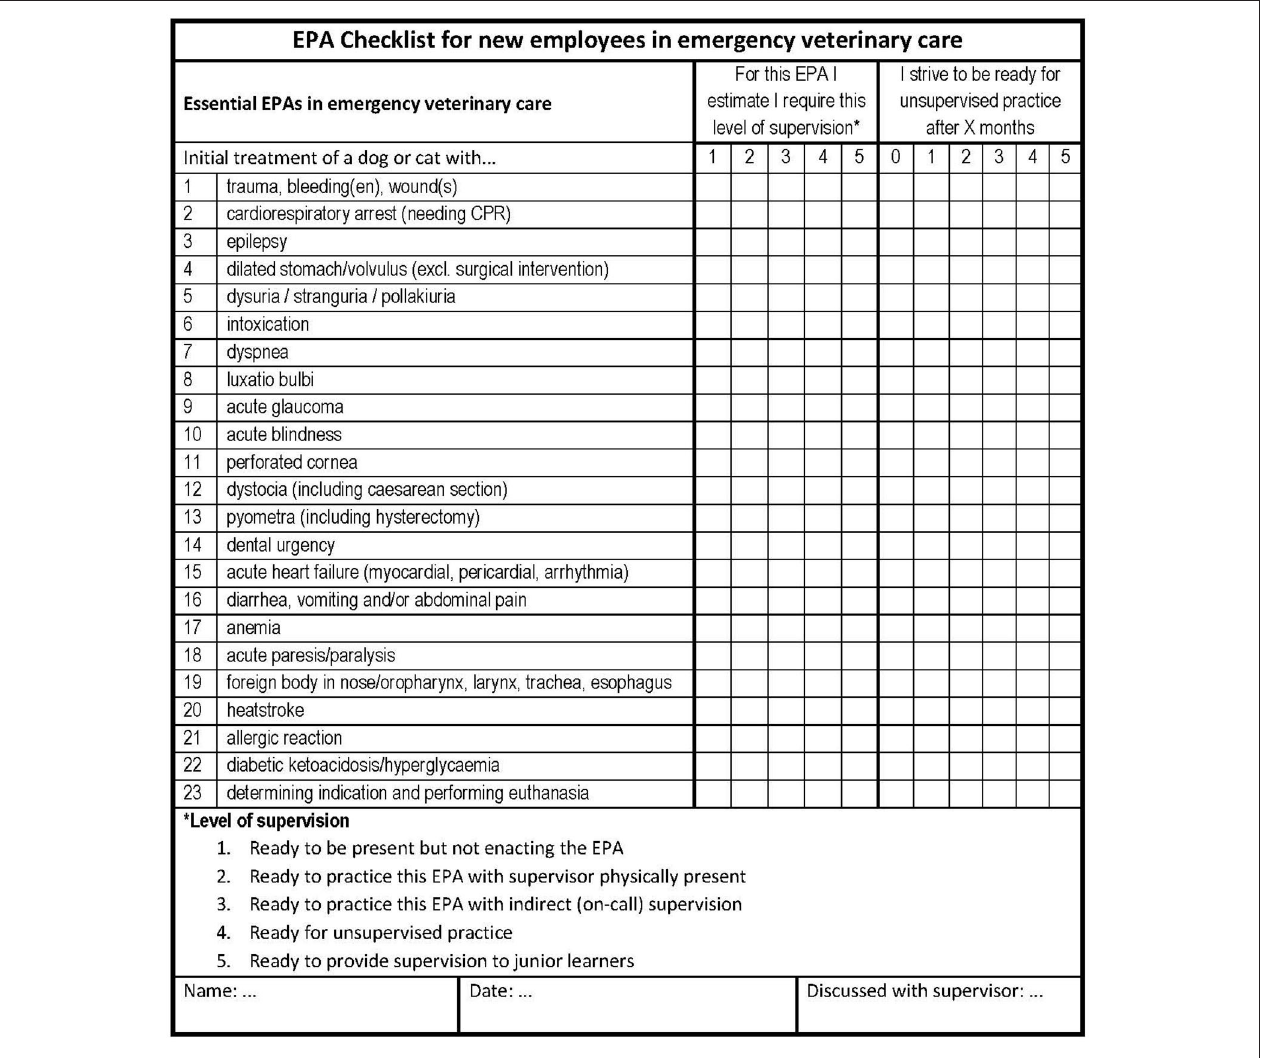
FIGURE 1 | Proposed tool to manage supervision after transition (example from veterinary medicine).